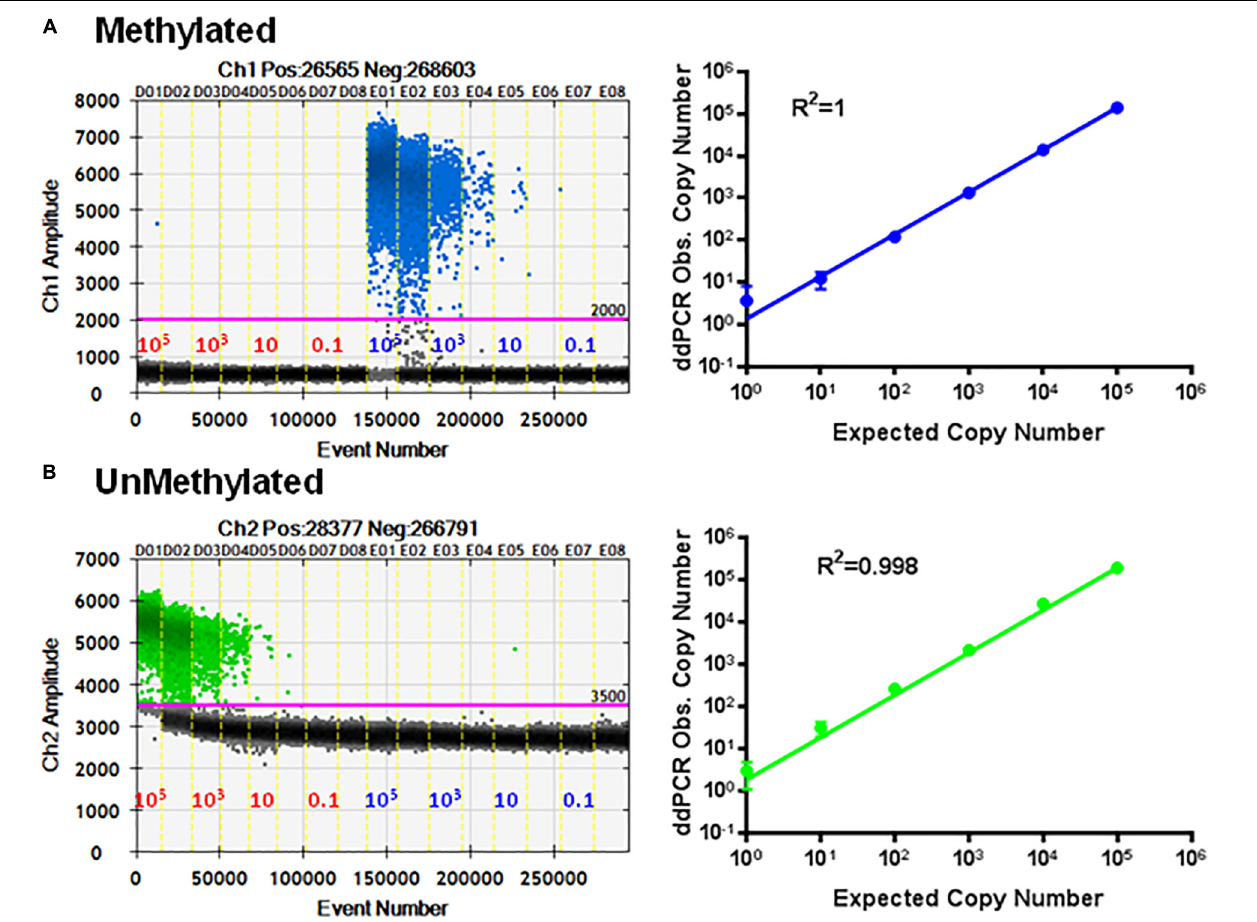
FIGURE 5 | Specificity of ddMSP assay. Standard curves of methylated (A) and unmethylated (B) FOXP3 TSDR in the same reaction. ddPCR using serially diluted mixed plasmids (10 5 –0.1 copy/reaction) and two TSDR-specific primers with probes for methylated and unmethylated CpGs. Standard curves with linear regression analysis of methylated and unmethylated targets. The data shown are the average with standard deviation (SD) of three